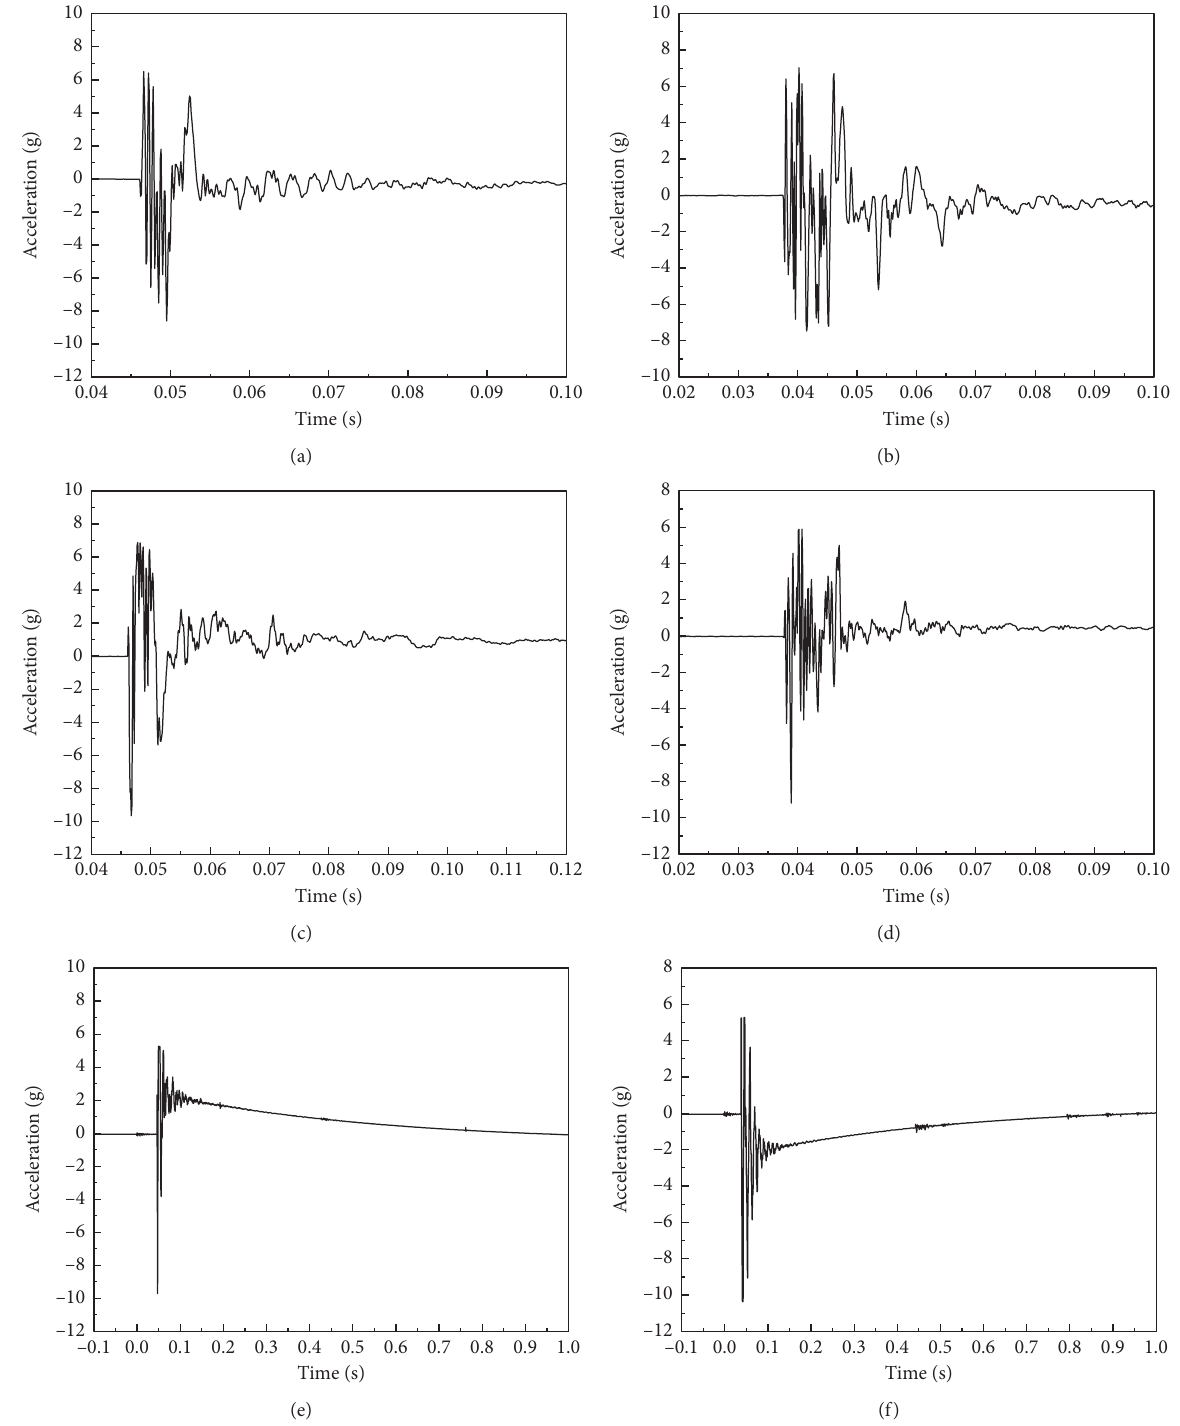
Figure 11: Comparison of vibration acceleration between A0 and B0. (a) X direction of A0. (b) X direction of B0. (c) Y direction of A0. (d) Y direction of B0. (e) Z direction of A0. (f) Z direction of